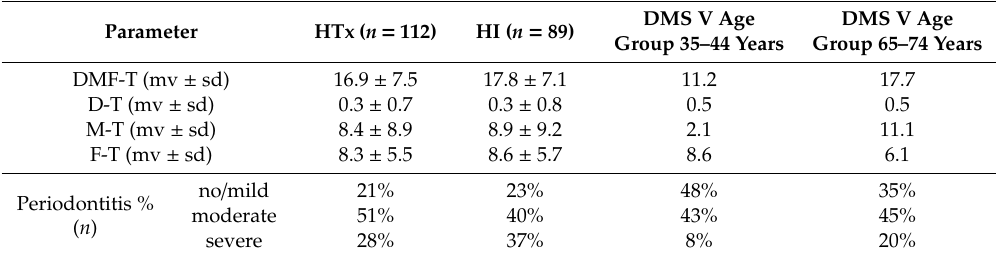
Table 6. Comparison of dental findings with the Fifth German Oral Health Study (DMS V) (Jordan et al.